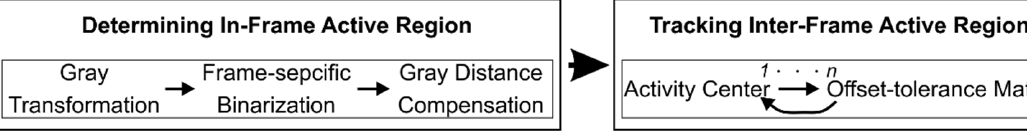
Figure 1. Block diagram for segmenting and tracing active regions.